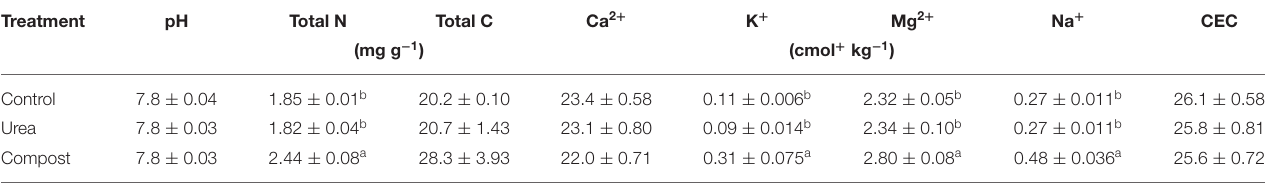
TABLE 1 | Chemical properties of soils fertilized with urea or compost, compared to an unfertilized control ( n = 3).